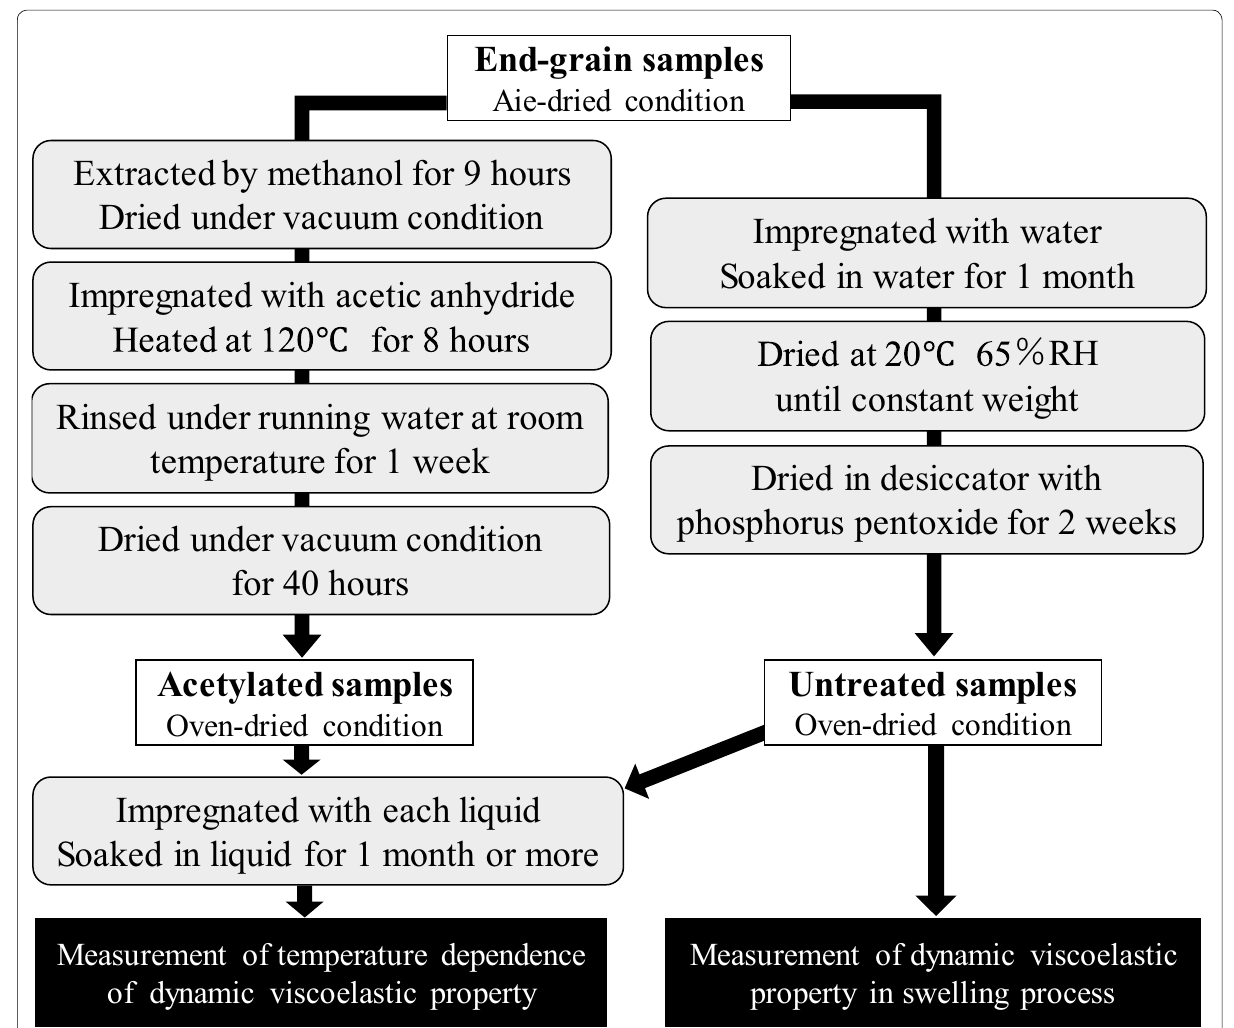
Fig. 2 Scheme of the sample treatment